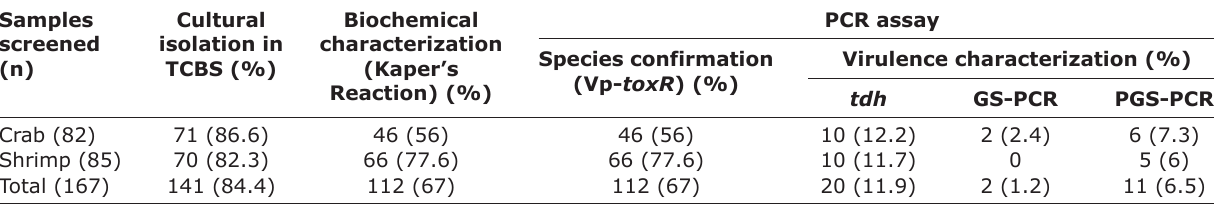
Table-1: Occurrence of V. parahaemolyticus in shellfishes. Samples screened